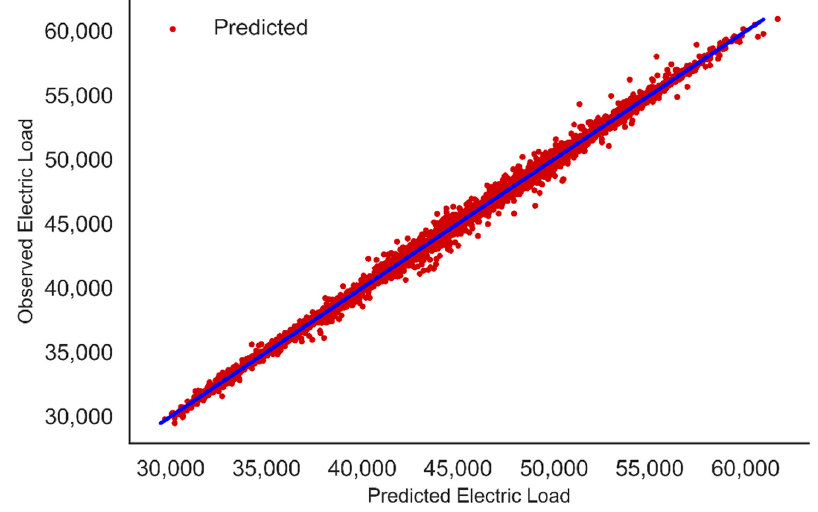
Figure 10 . Predicted versus actual load by XGBoost model.